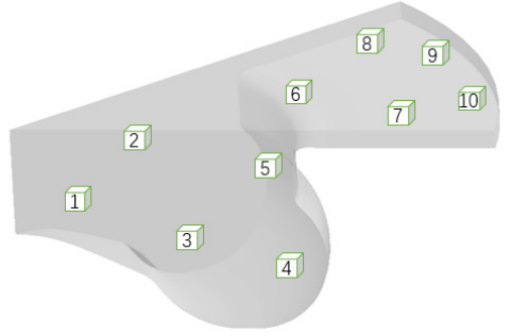
Figure 3. Distribution of the defined ten local regions (R1–R10).